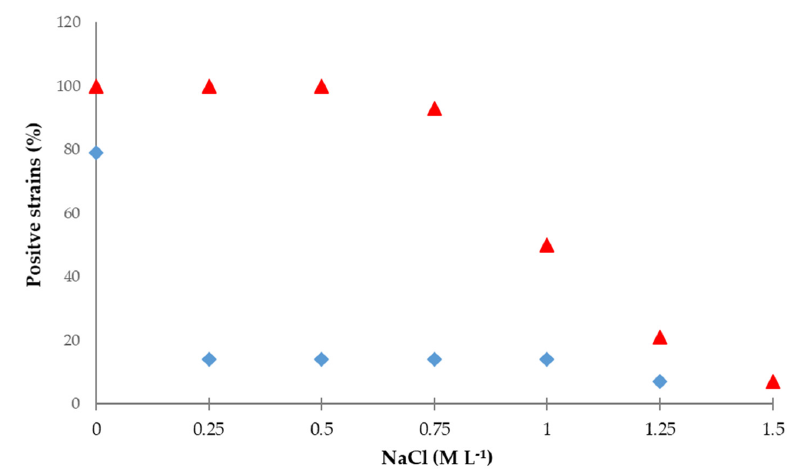
Figure 1. Hydrocyanic acid (HCN, in blue) and ammonia (NH 3 , in red) production by the strains under different NaCl concentrations.